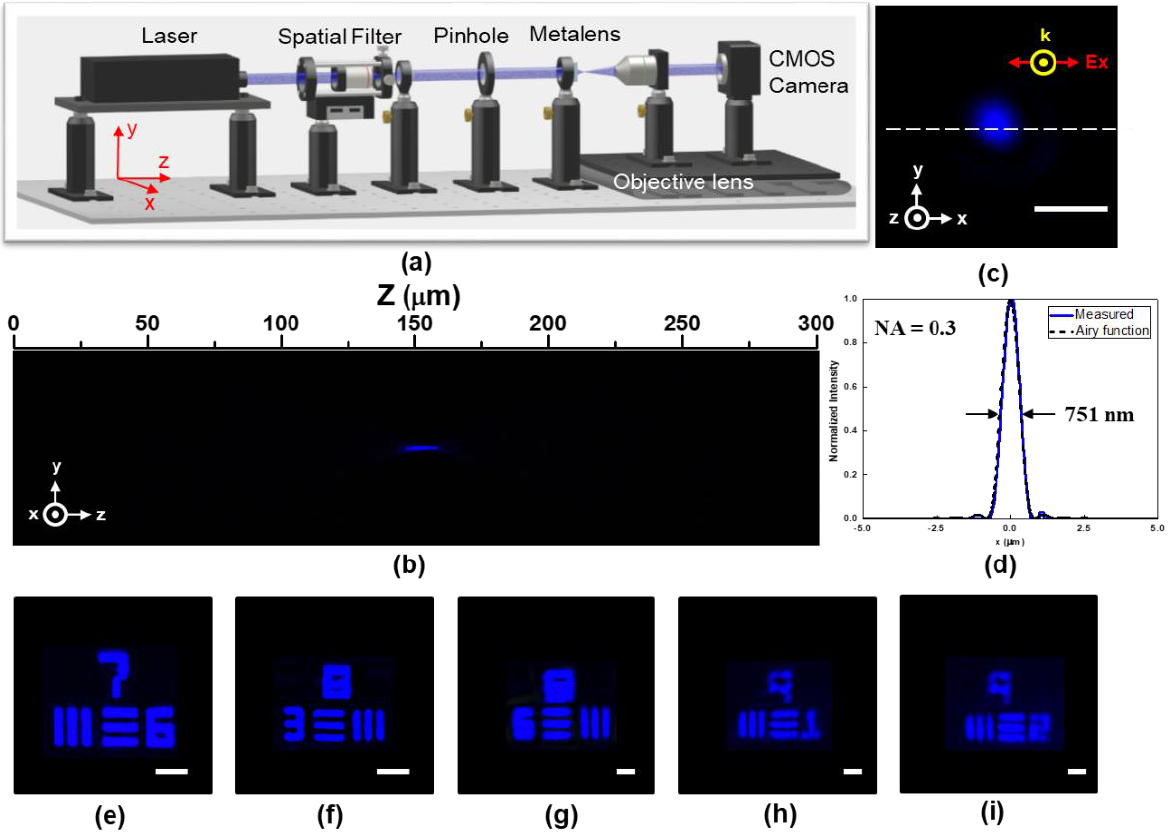
Figure 4. ( a ) Schematic for illustrating the measurement setup for diffraction-limited focusing; ( b ) the y-z plane cross-sectional image; ( c ) measured focal spot profile (x-y plane); ( d ) the cross-sectional intensity distribution of the focal spot, with the dashed line indicating the ideal Airy function; and ( e – i ) the measured images using 1951 USAF as the target, scal e bar: 10 μm in ( e,f ), scale bar: 3 μm in ( g – i ).